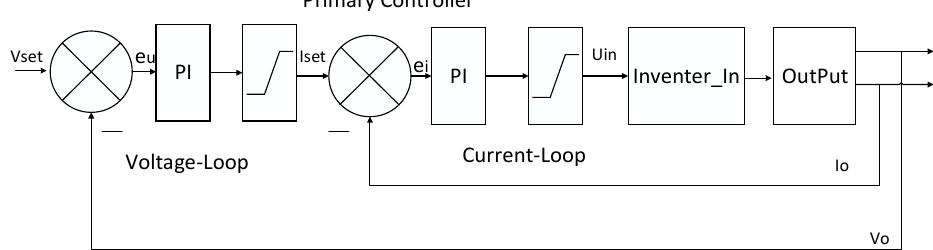
Figure 17. Flow chart of the raw edge closed loop. When the system first starts to work, due to the low battery voltage, the voltage error is large, resulting in PI controller saturation. The system starts to charge the battery with a constant current. When the battery voltage reaches the desired voltage set by the system, through the calculation of the system voltage error is less than 0, the voltage PI controller withdraws from its saturation state, the current error is always close to 0, the current loop does not work, and the working condition of the system is constant voltage output until the end of charging.